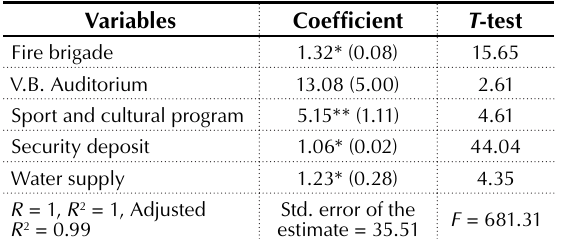
Table 8. Regression results for capital receipts